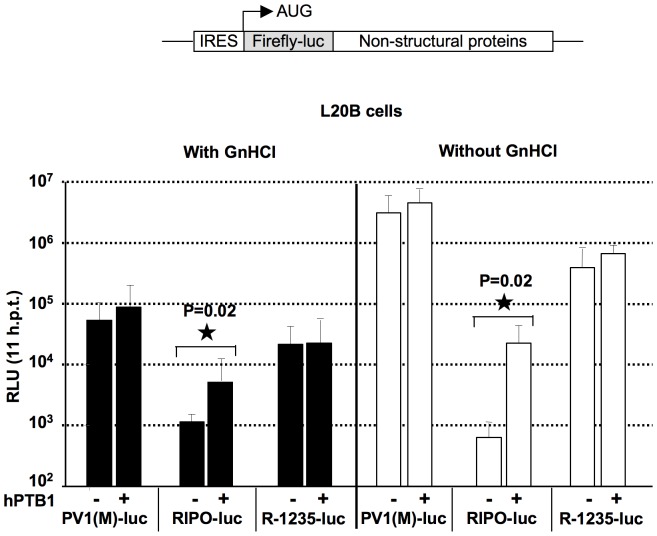
RNA translation and replication of PV1(M)-luc, PV1(RIPO)-luc, and R-1235-luc replicons.Monolayers of mouse L20B and L20BhPTB1 cells were transfected with in vitro transcribed RNA of luciferase replicons and incubated at 37°C in the presence (for translation) or in the absence (for replication) of 2mM guanidine hydrochloride (GnHCl). RNA translation and RNA replication were assessed by measuring the luciferase activity at 11 h post transfection. In all cases, averages ± SD of at least three independent experiments are shown; <$>\raster="rg1"<$> denotes student t-test p value <0.05.